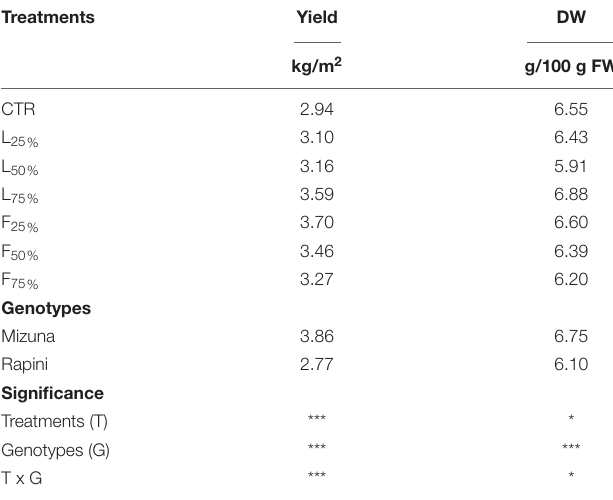
TABLE 6 | Yield and dry weight (DW) of Brassica rapa L. Mizuna and Rapini group microgreens, produced in greenhouse, as effected by Posidonia oceanica (L.) Delile (PO) leaves (L) and fibers (F) in the growing media.